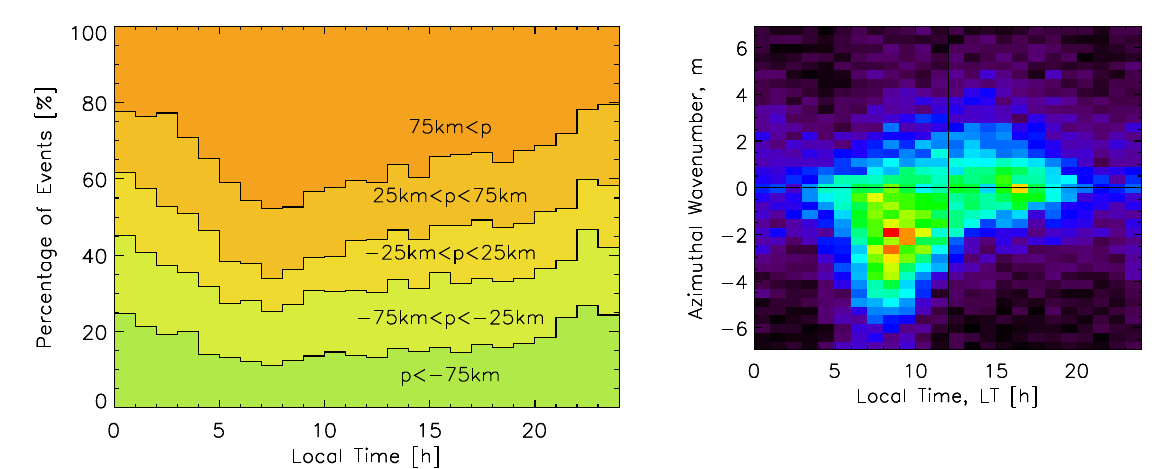
Fig. 10. Distribution of events with respect to the azimuthal wavenumber m and local time of occurrence. Binning of m axis: 0 .